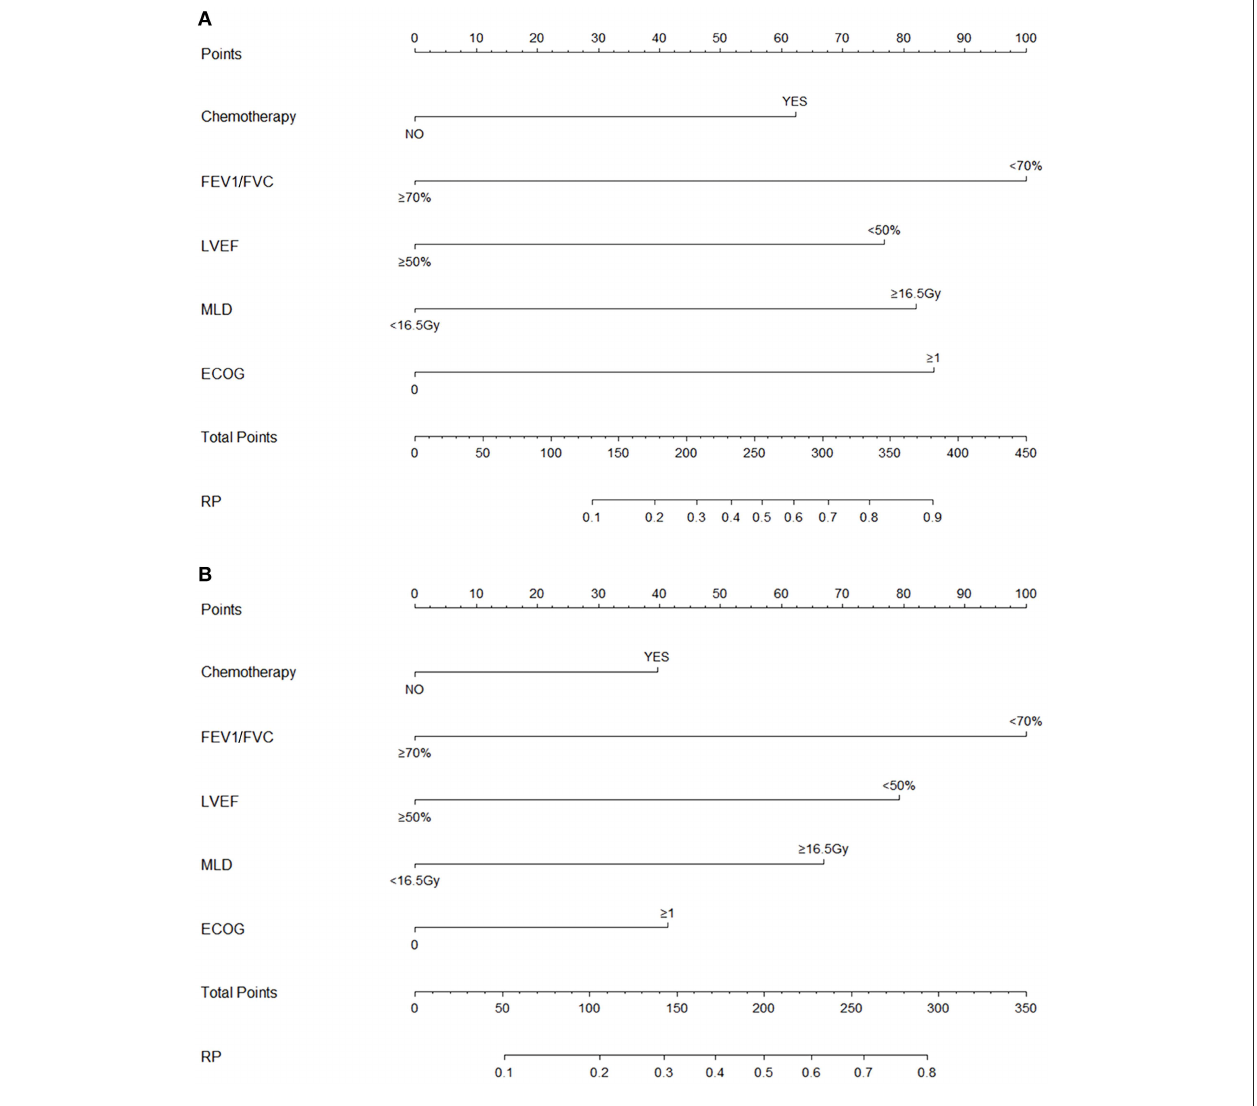
with heart failure with mid-range ejection fraction